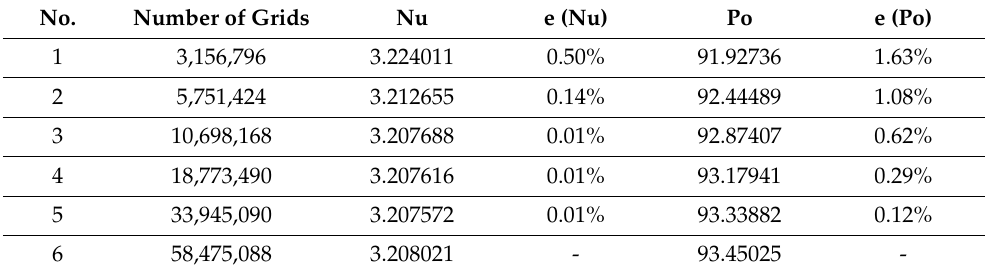
Table 3. Results of simulation validation.